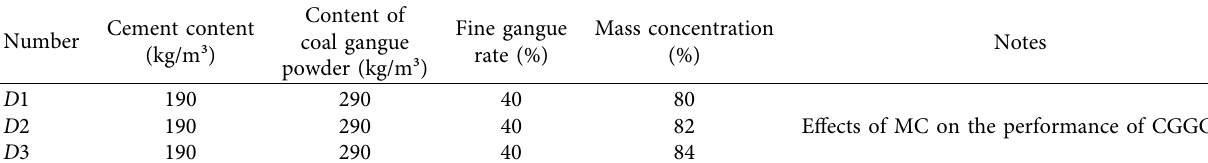
Figure 4: XRD difraction map of coal gangue. Table 4: Mix proportion of CGGCFB performance